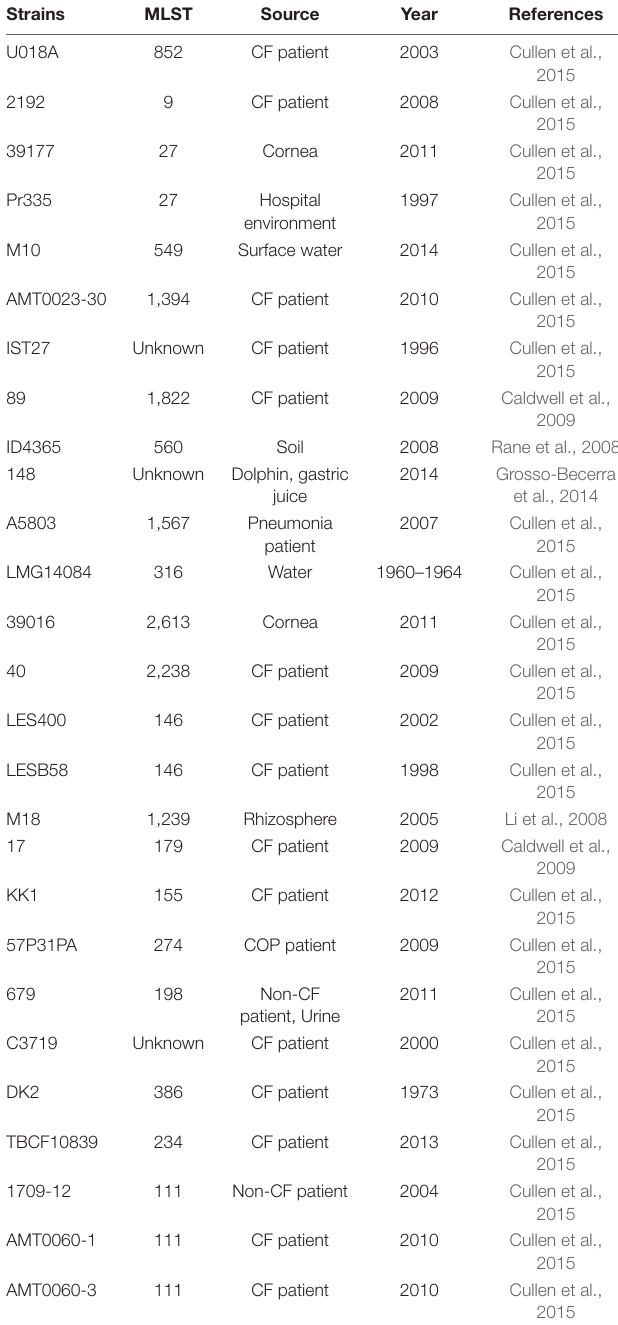
TABLE 2 | Information of pyocyanin-producing P. aeruginosa